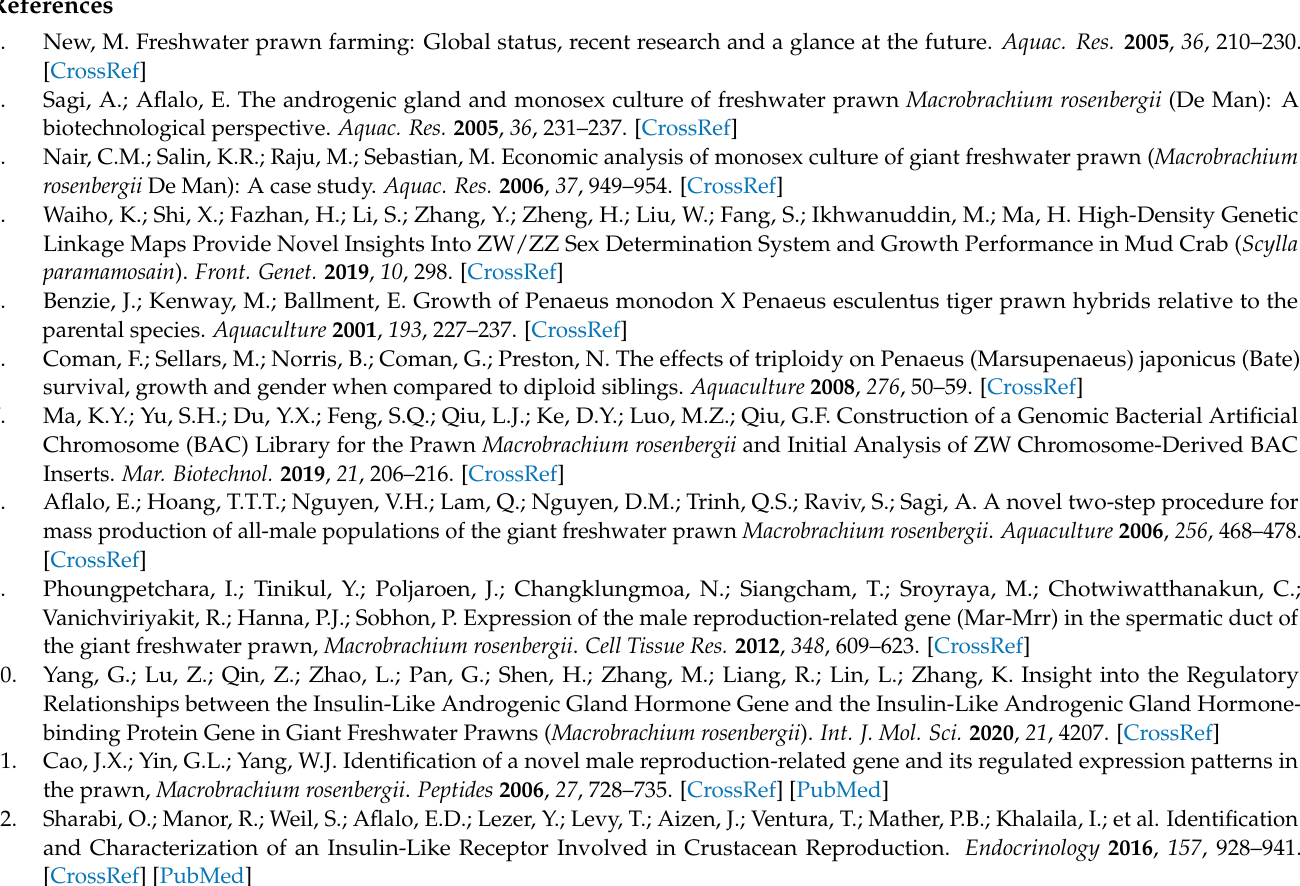
signaling pathway of the DEGs. Figure S1, length distribution of unigenes of testis and ovarian transcriptome of M. rosenbergii. Figure S2, number of unigenes annotated to different databases. Figure S3, distribution of the top 10 species with high sequence similarity to M. rosenbergii unigenes. Figure S4, GO classification of the assembled unigenes of M. rosenbergii of testis and ovary. Figure S5, KOG annotation analysis of the